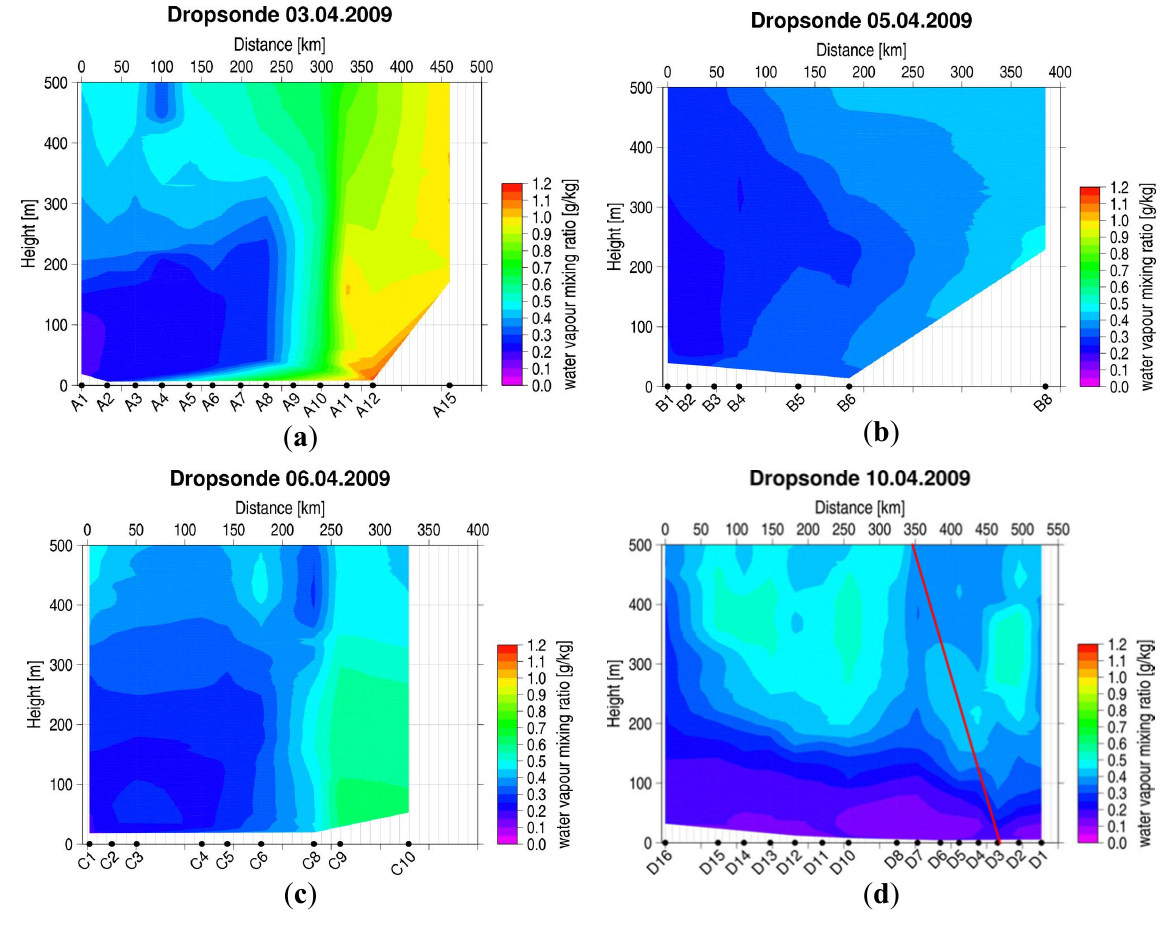
Figure 7. Water vapor mixing ratio as retrieved from dropsonde measurements on 3 ( a ), 5 ( b ), 6 ( c ) and 10 April ( d ) 2009. The red line in panel d indicates the location of the front determined from the strongest horizontal temperature